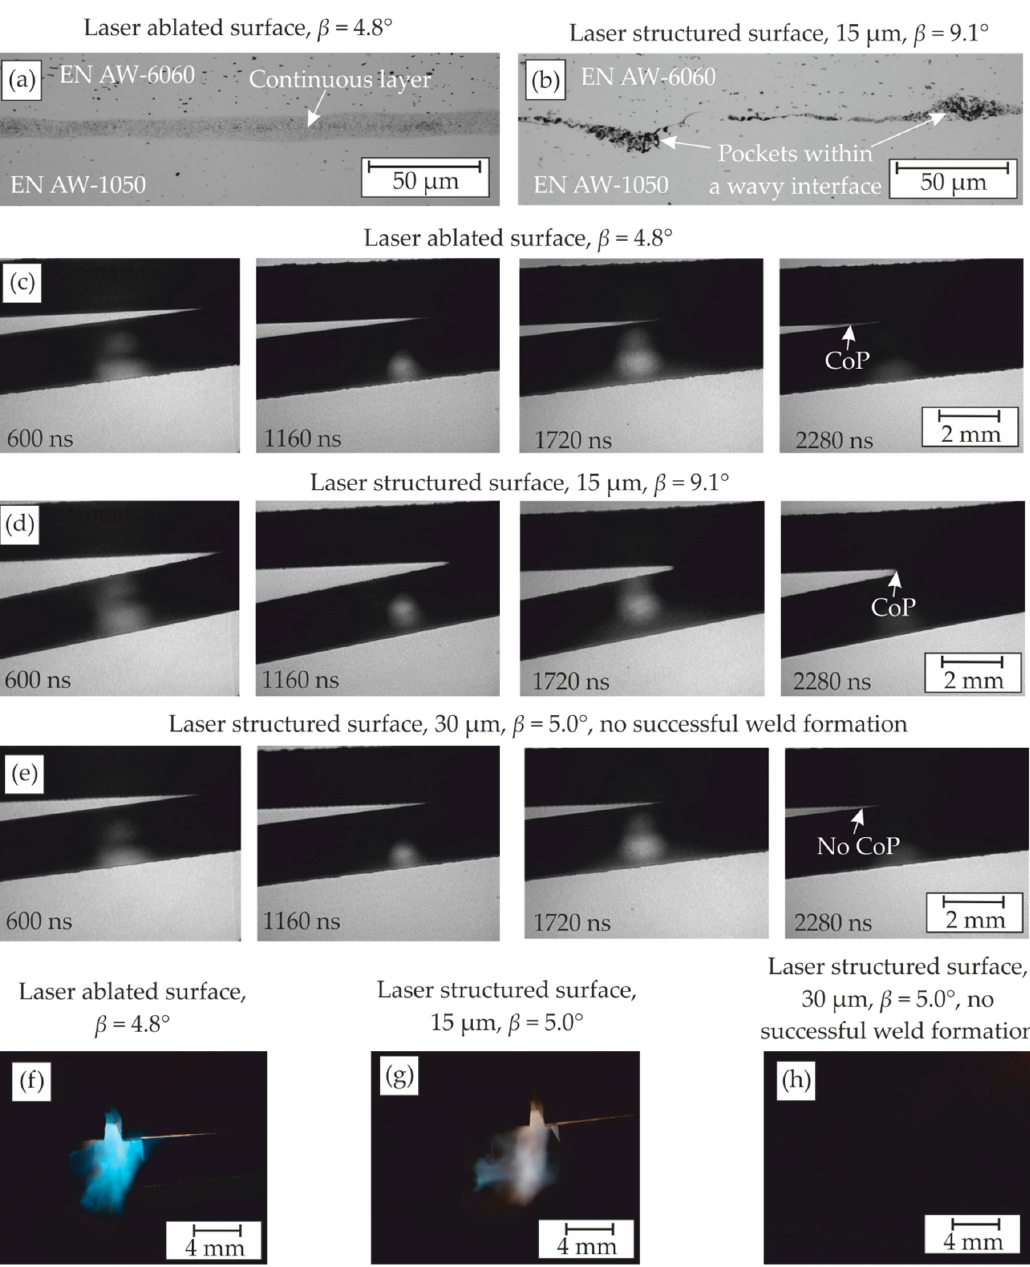
Figure 6. Influence of the surface structure on ( a , b ) the joining zone in polished cross sections, ( c – e ) the formation of a cloud of particles, and ( f – h ) the process glare at v imp = 262 m/s. Welding direction to the left from the initial collision point.